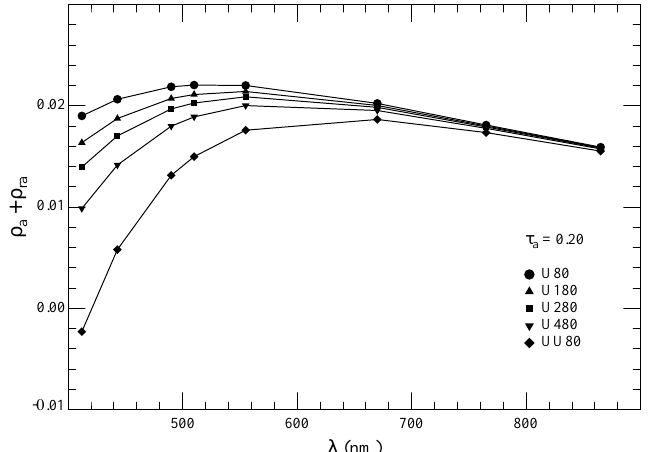
Figure 7. Influence of the physical thickness of the aerosol layer on the spectrum of ρ a + ρ ra = ρ A . For U80 the aerosol is confined to a thin layer near the surface, while for U180, U280, U480, and UU80, the aerosol is uniformly mixed with air to a height of 1 km, 2 km, 4 km, and the whole atmosphere, respectively. Viewing is near nadir and θ 0 = 60deg and τ a ( 865 ) = 0.2. From Gordon, Du, Zhang